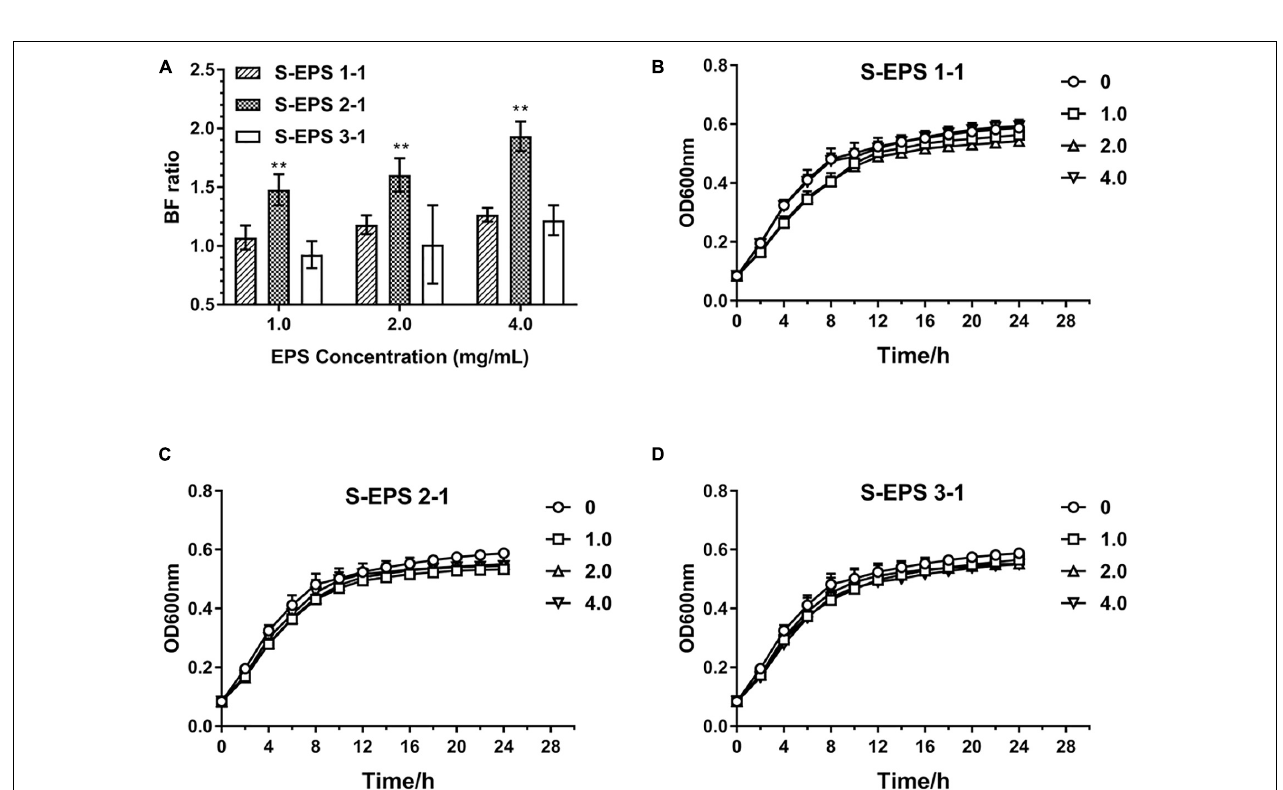
FIGURE 6 | Biofilm formation ratio of S. flexneri after cultured with different concentrations of S-EPS 1-1, S-EPS 2-1, and S-EPS 3-1 (1.0, 2.0, and 4.0 mg/ml) for 24 h (A) ; “**” indicated significant difference with other groups, p < 0.01. Growth curve of S. flexneri cultured with different concentrations of (B) S-EPS 1-1, (C) S-EPS 2-1, and (D) S-EPS 3-1 (1.0, 2.0, and 4.0 mg/ml) for 24 h.